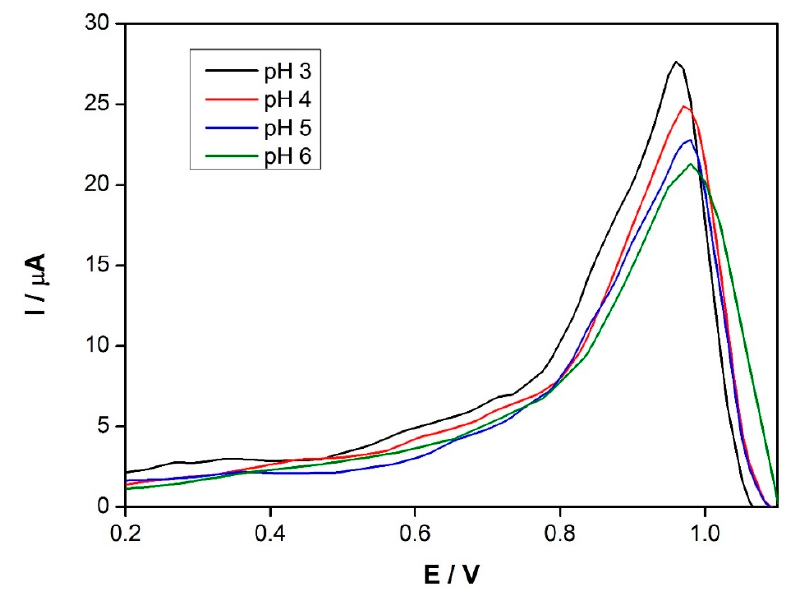
Figure 4. Square wave voltammetry (SWV). Enrofloxacin samples prepared at 3 mM concentration in different pH buffer solutions.